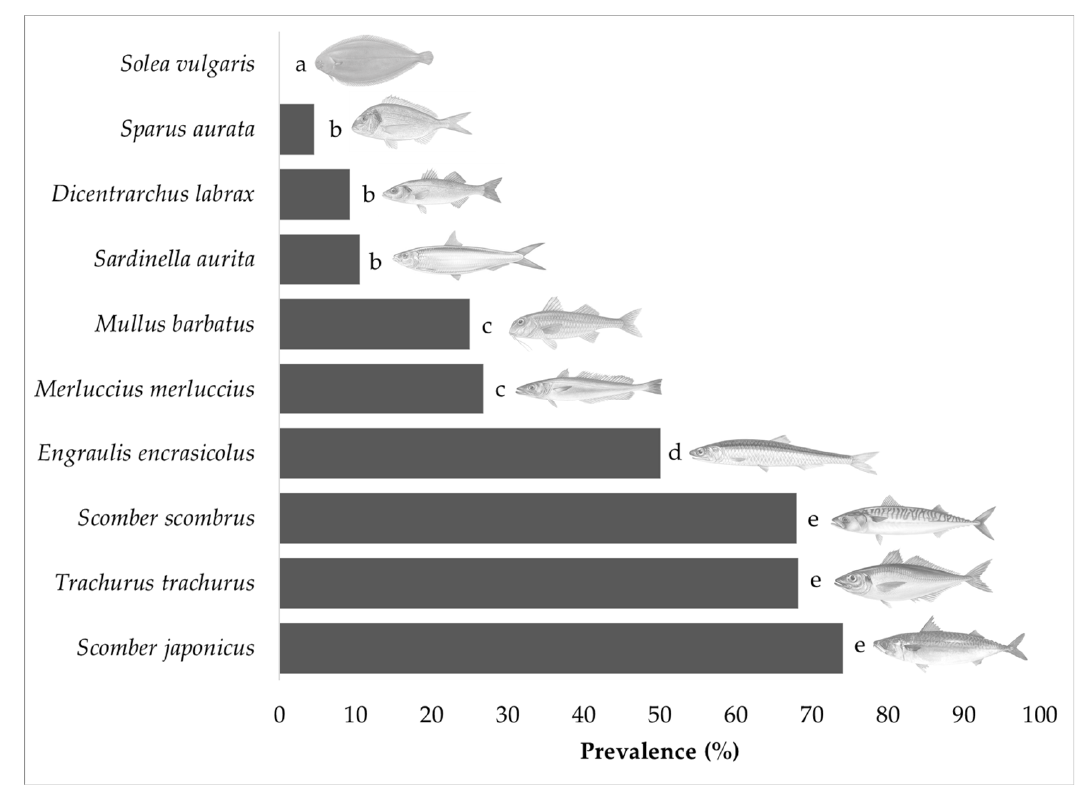
Figure 3. Prevalence (%) of anisakid L3 type I larvae in the fish species. Bars sharing the same letters are not significantly different ( p < 0.05).